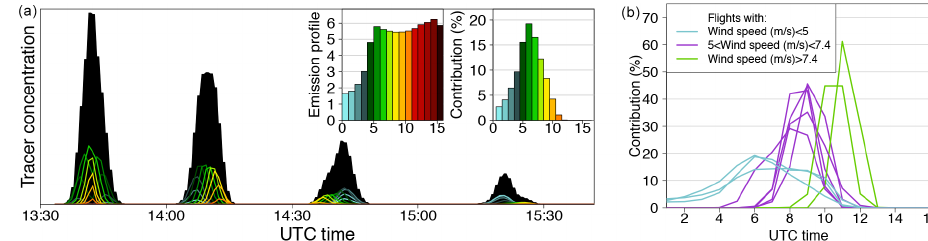
Figure 9. (a) Concentration along the flight trajectory of the 16 tracers (colored lines) and their total (black) during the 28 July flight. The emission profile gives the color associated with each tracer as well as their emission intensity. The hourly emissions contribution over all peaks of each tracer to the total (in terms of area) is shown in the top right corner. (b) Hourly emission contribution to total area for all flights. For each flight there is a corresponding line colored according to the mean wind speed in altitude given in Table S3 in the Supplement. Note that, as flights occur in the afternoon, only the first 16h of the day are